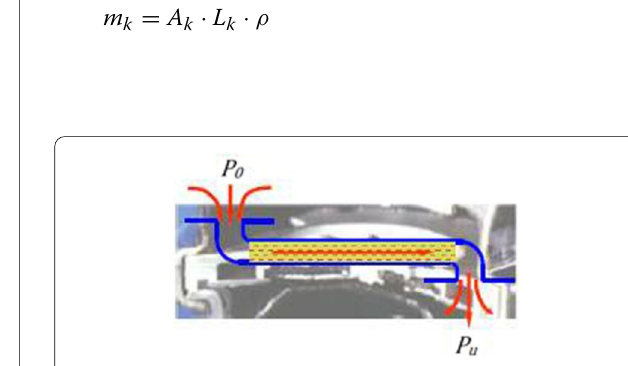
Figure 1 Schematics of hydraulic mount mechanical model Figure 2 Inertial channel